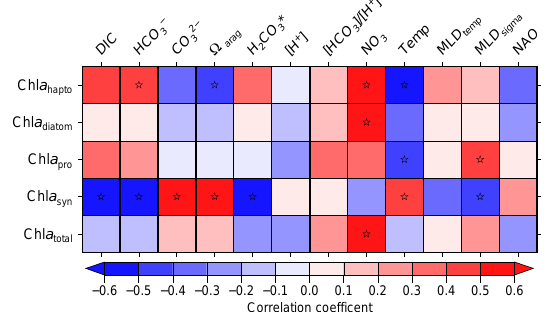
Figure 3. Correlation coefficients between Chl a components and various oceanographic measurements made in the upper 30m of the water column at BATS, NAO index, calculated mixed-layer depth (MLD; see Sect. 2) and derived carbonate chemistry parameters. Stars indicate the absolute value of the correlation coefficient is greater than